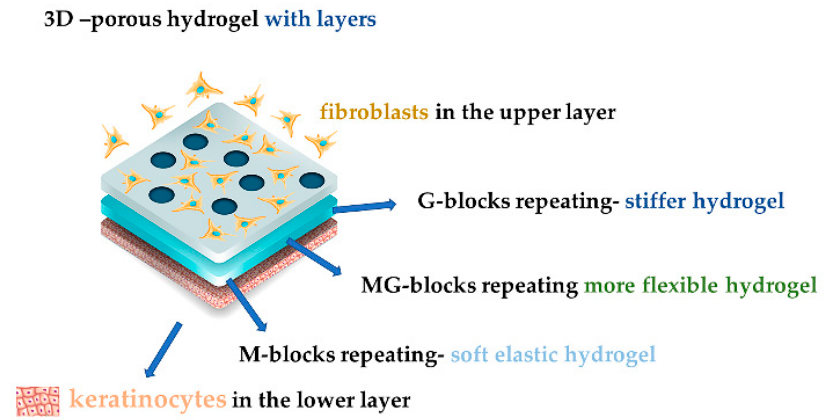
Figure 2. A 3D model of porous hydrogel with fibroblasts and keratinocytes.